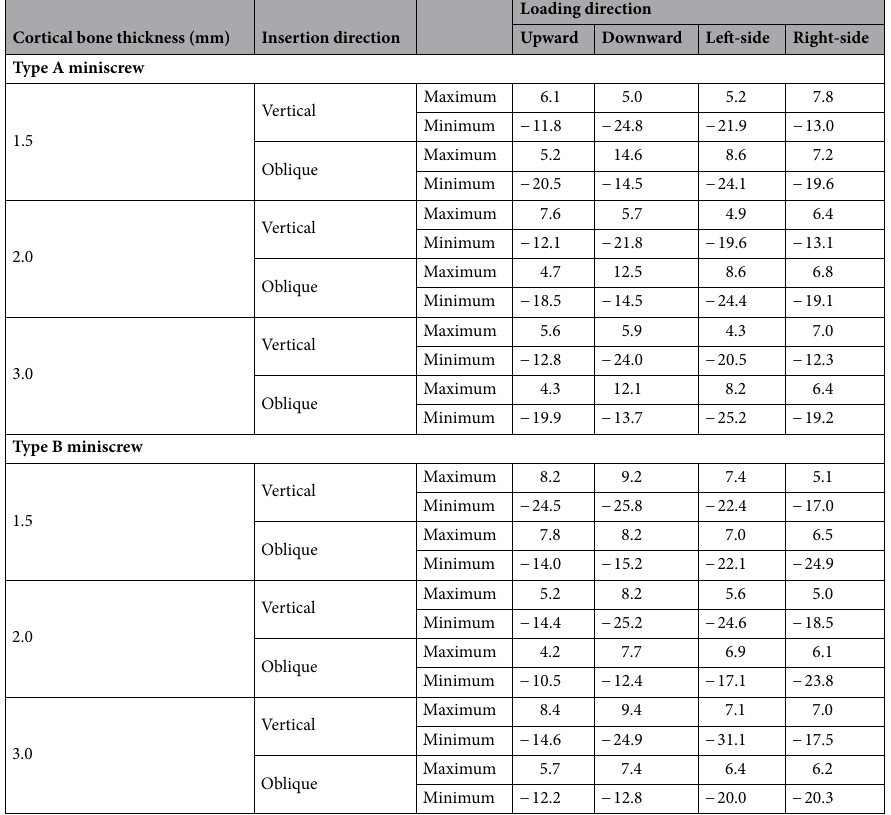
Table 3. Greatest maximum and smallest minimum principal stresses (MPa) on the surface of the modeled cortical bone when the miniscrew was placed vertically or obliquely in each cortical bone